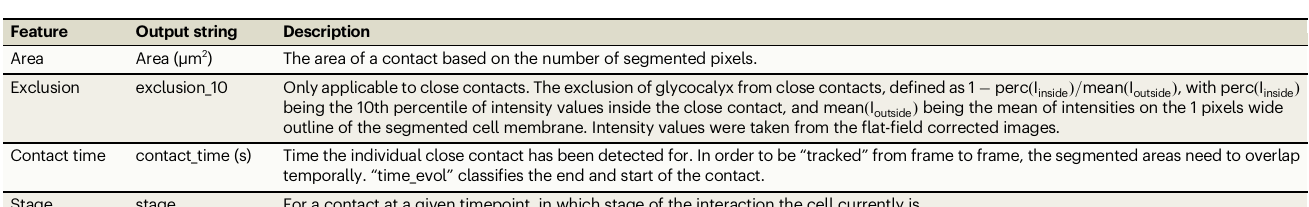
Table 3 | Contact features and